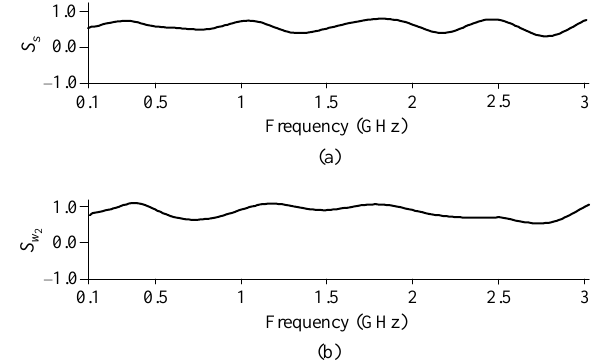
Fig. 9. Impact coefficients on the input impedance of a system when changing: (a) the gap s between adjacent meander conductors; (b) the width w 2 of additional shield.